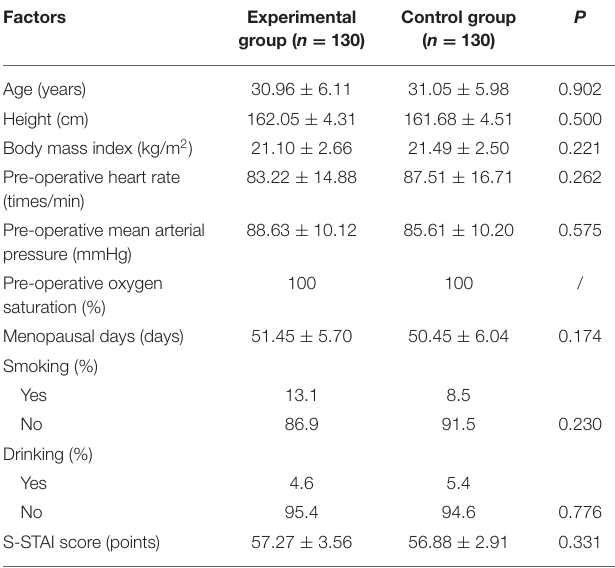
TABLE 1 | Patient characteristics.